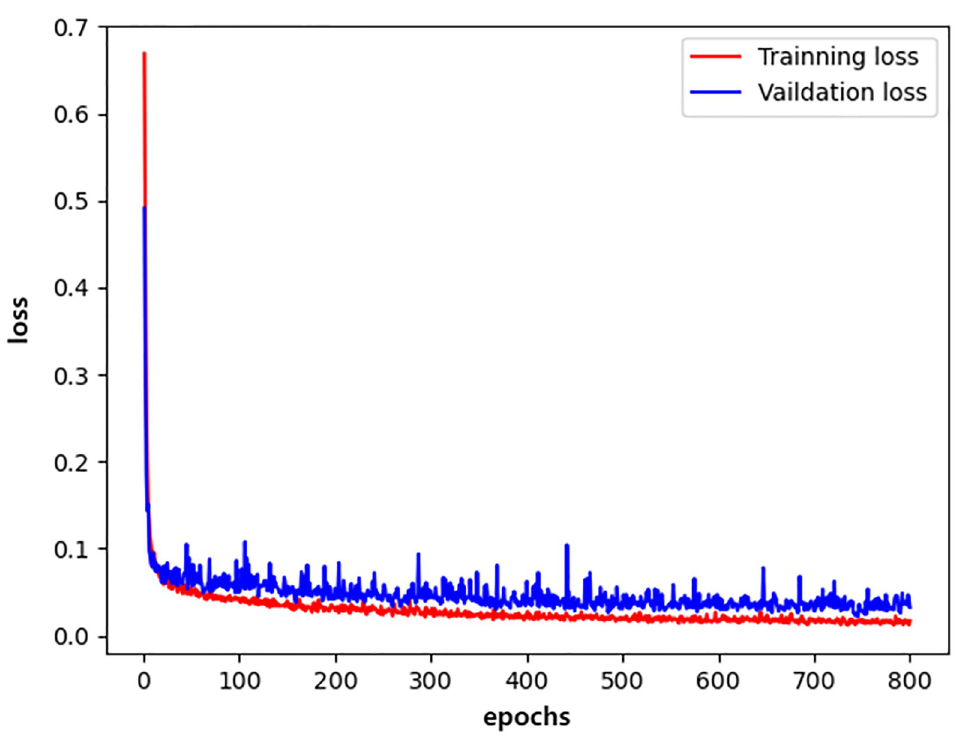
Fig 10. densenet_loss.